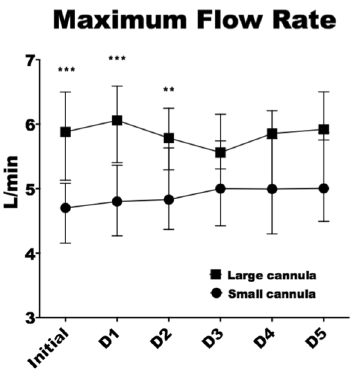
Fig. 1 Difference and evolution of maximum ECMO flow rate in patients with small (n 60) and large inlet cannula (n =